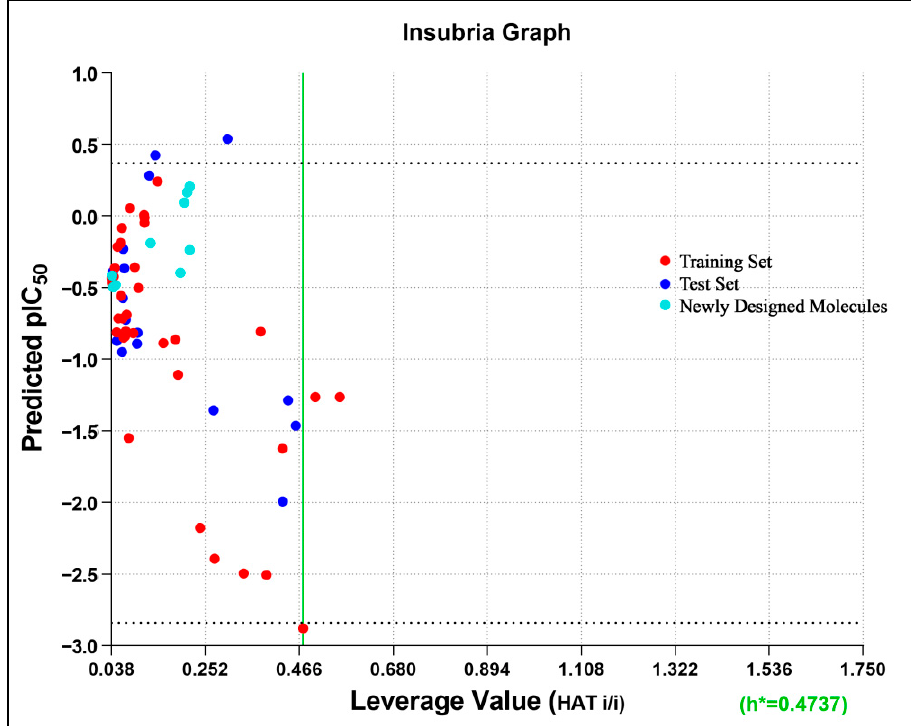
Figure 13. Insubria plot (plot of leverage hat values vs. predicted activity) of all data points. h* represents the threshold leverage value.